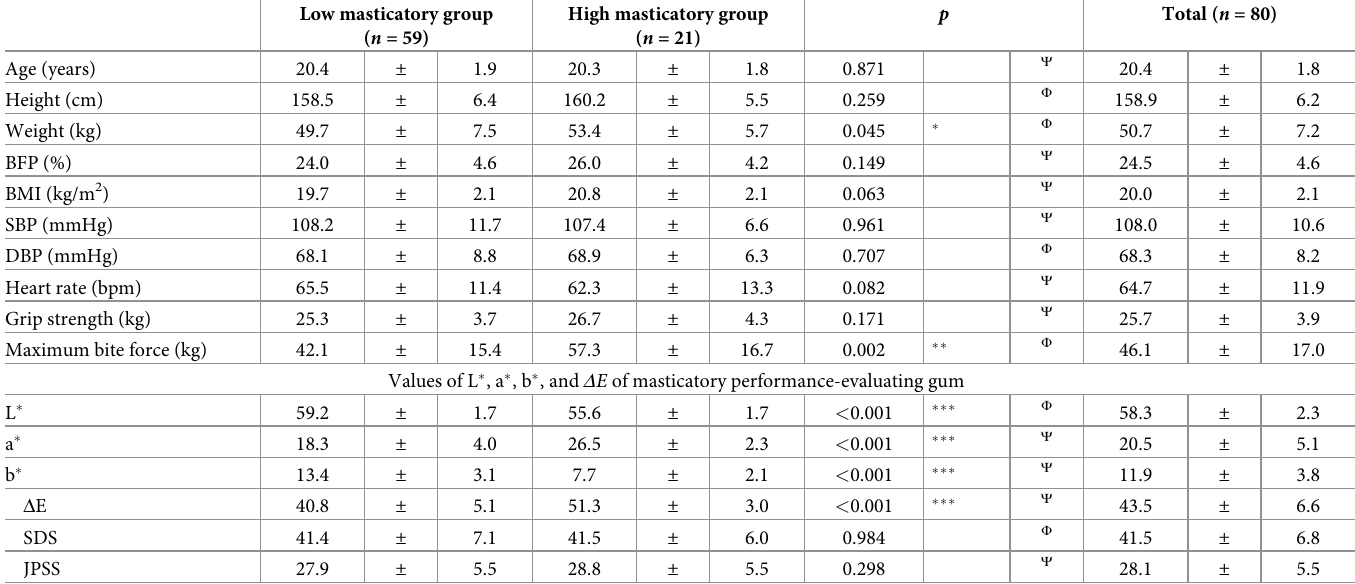
Table 1. Basic characteristics of the